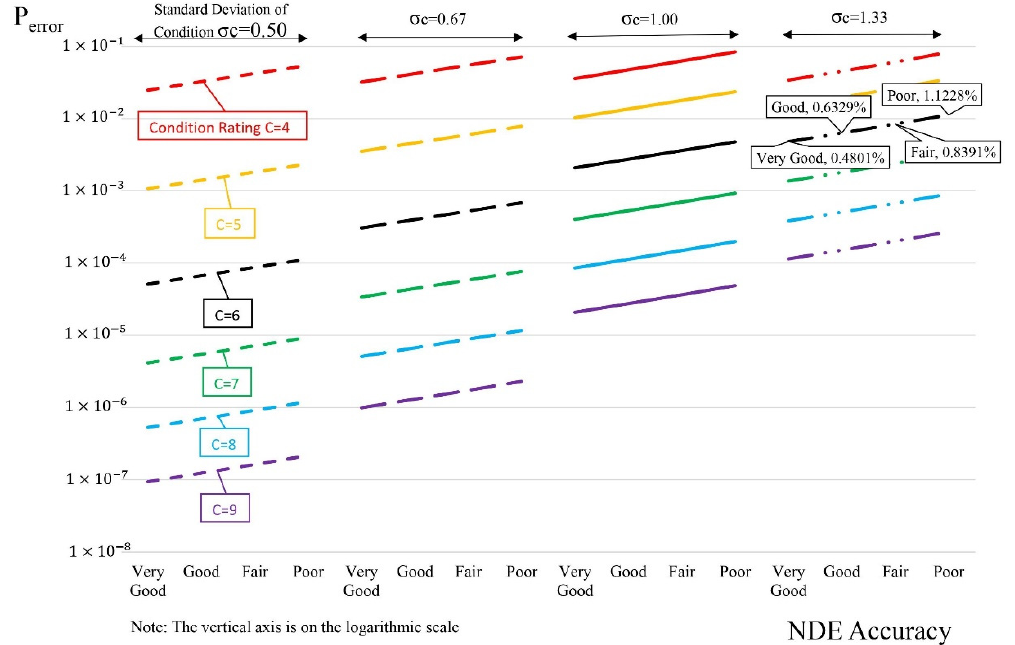
Figure 12. Probability of false negative inspection report (P error ) based on involved parameters.